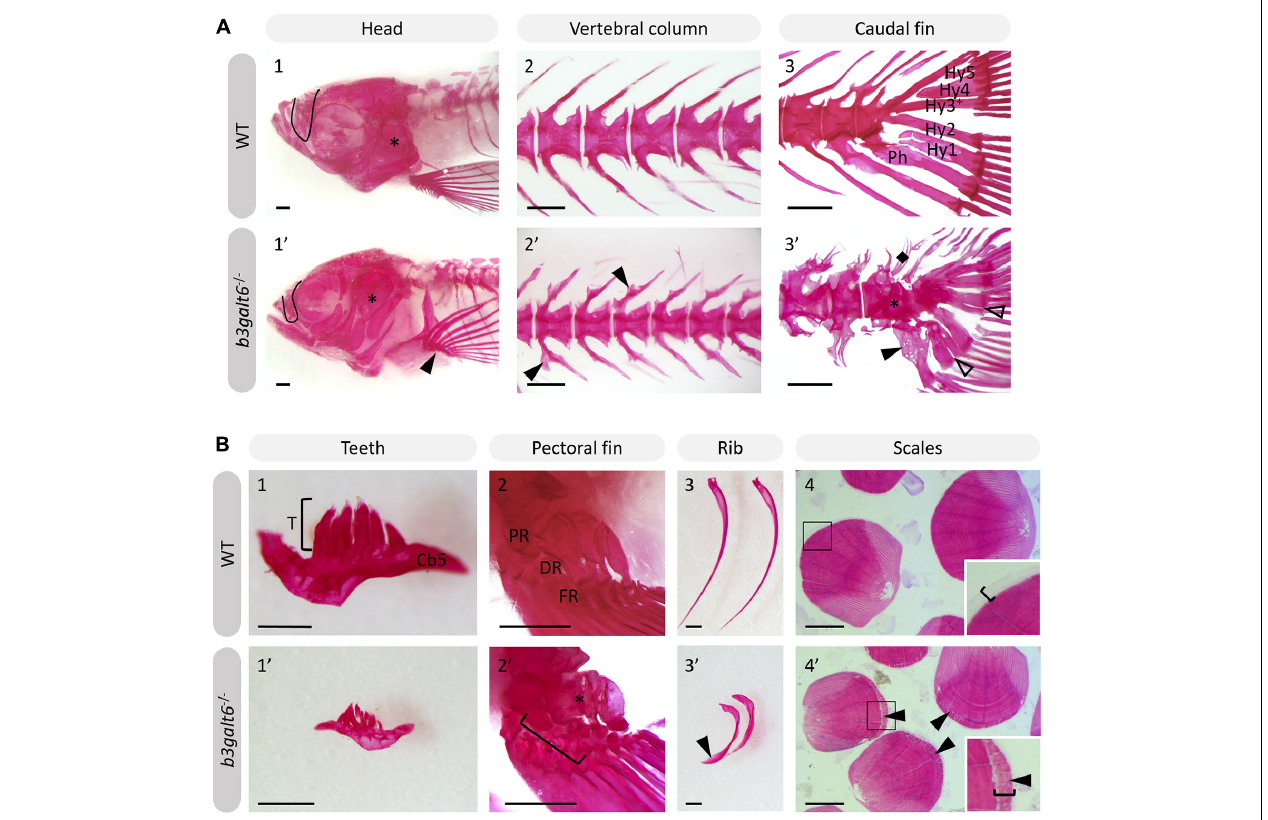
FIGURE 5 | Alizarin red stained mineralized bone in WT and b3galt6 − / − adult zebrafish. The mineralized bones in the skeleton were studied in 4 months old WT and mutant zebrafish after AR mineral staining. (A) b3galt6 − / − zebrafish display malformation of the cranium, vertebral column and caudal fin. (A1-1’) The cranium shows an underdeveloped olfactory region (black line) and a smaller compacted opercular bone (asterisk). (A2-2’) The vertebral column shows extra intramembranous outgrowths located where the distal tip of the neural and haemal arches fuse to a neural and haemal spine, respectively (arrowheads). (A3-3’) In the caudal fin fusion of preural vertebrae is observed (asterisk). Associated elements show intramembranous outgrowths (arrowhead) and the presence of extra bony elements (diamond). The distal tip of the hypurals is sometimes split (transparent arrowhead). Structures indicated in the WT caudal fin: Hy1-5, hypural 1-5, Ph, parhypural. (B) Details of mineralized structures in b3galt6 − / − zebrafish. (B1-1’) The fifth ceratobranchial arch and its teeth are smaller in KO zebrafish. (B2-2’) The proximal (PR) and distal radials (DR) have irregular shapes in mutant zebrafish. Proximal (asterisk) and distal radials are sometimes fused. The bracket indicates a fusion between a proximal and distal radial, and the first fin ray (FR). (B3-3’) Ribs also show extra intramembranous bone (black arrowhead). (B4-4’) More mineralization was observed at the growth zone (bracket) of the scales in mutant zebrafish (arrowhead). Scale bars = 500 µ